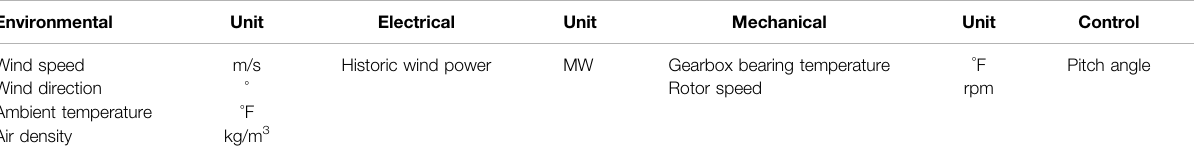
TABLE 1 | SCADA variables utilized in this study.